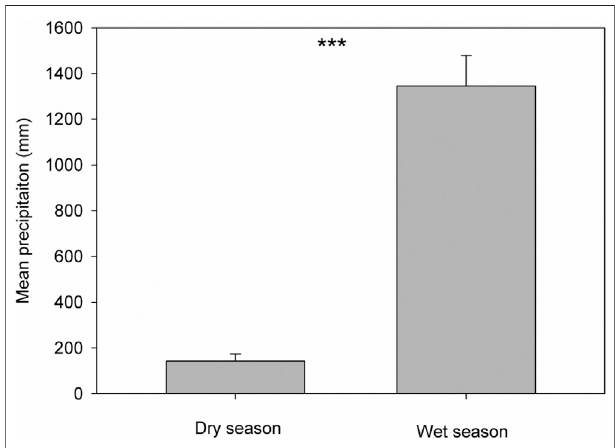
FIGURE 2 | Variations in mean precipitation in the dry season (February) and wet season (July) from 2016 to 2019. *** indicates p < 0.001, based on paired t